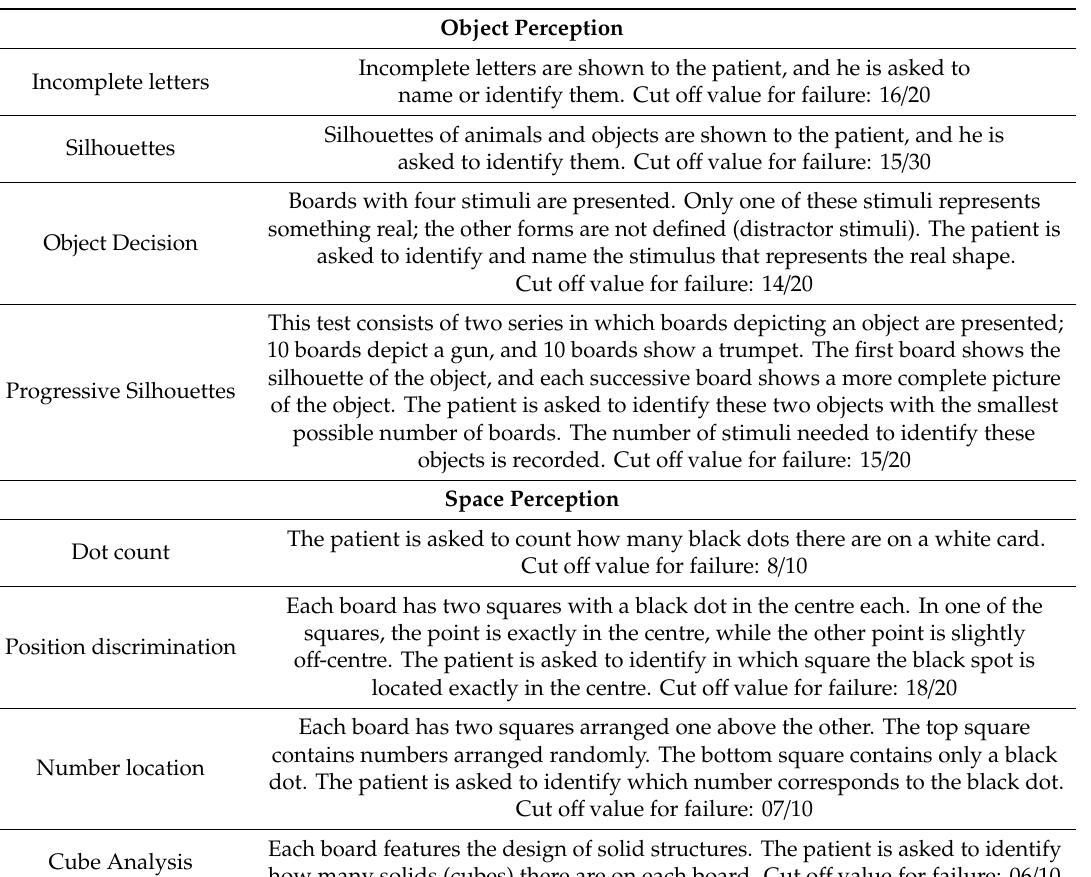
Table 1. A brief description of the tests with cut o ff values for failure based on scores from the VOSP